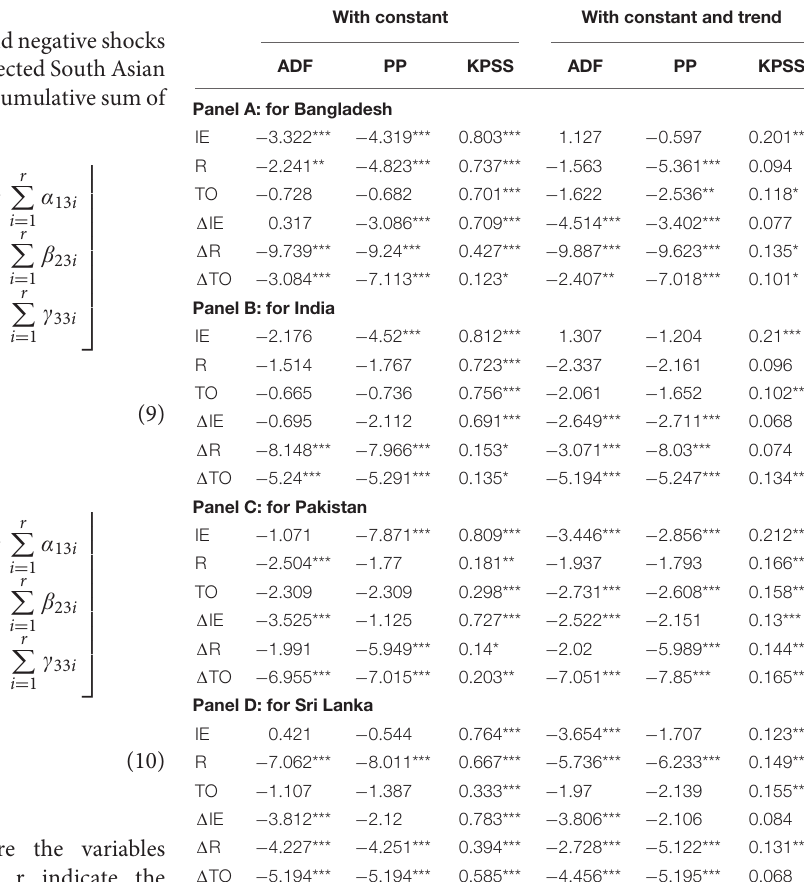
TABLE 2 | Conventional unit root